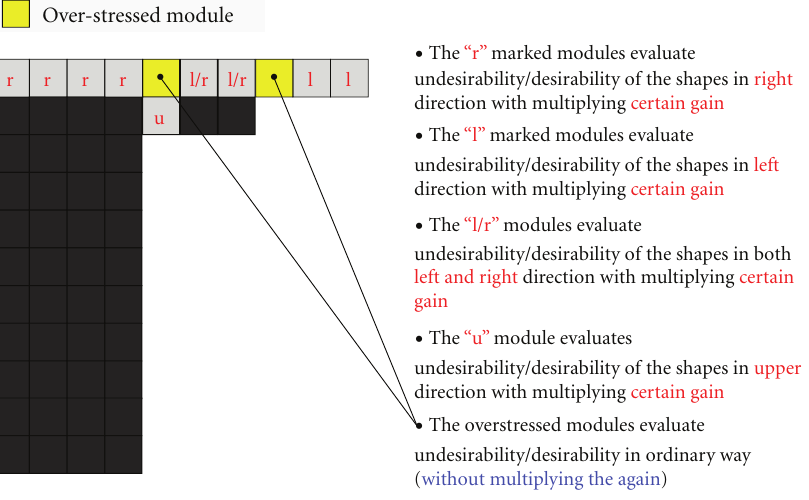
Figure 12: Alternation of the evaluation rule of undesirability/desirability of the shapes when there are overstressed modules in the